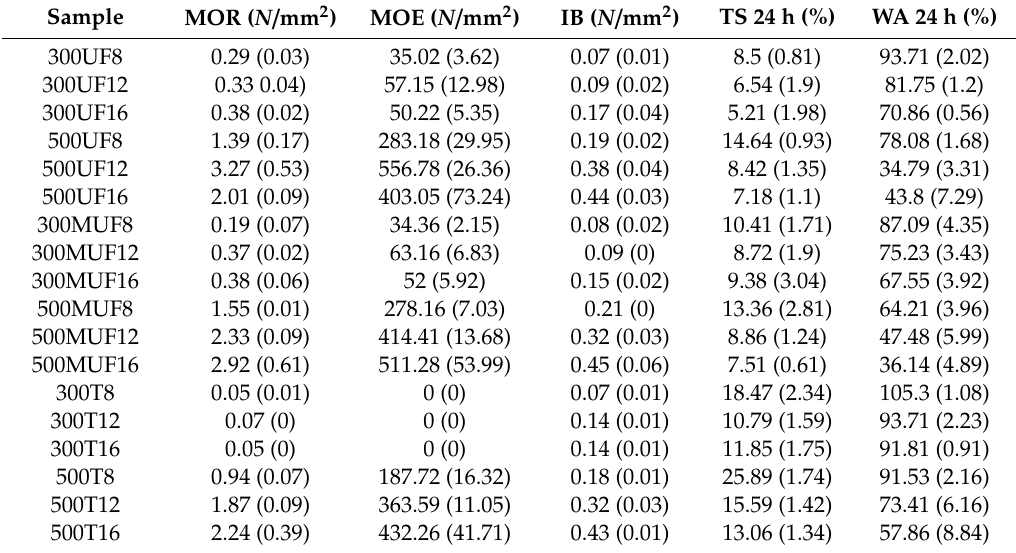
Table 2. Mechanical and physical properties of the larch-bark insulation panels (standard deviation in parentheses) .